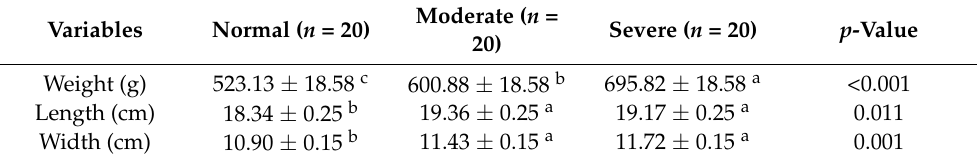
Table 1. Weight, length and breadth of breasts from broilers affected by wooden breast myopathy.